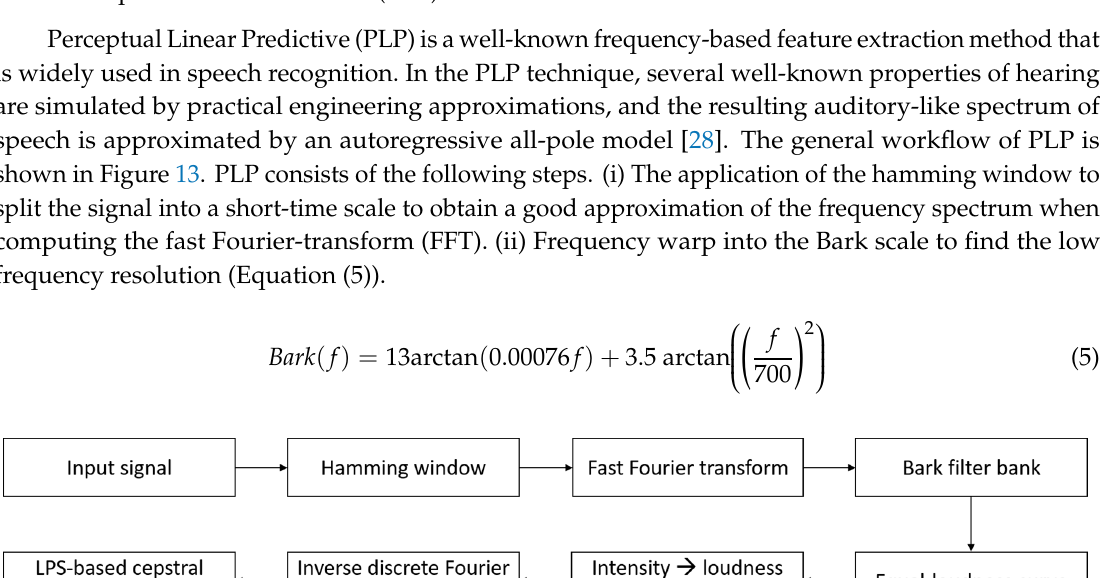
Figure 12. A proposed step for MFCC feature extraction.